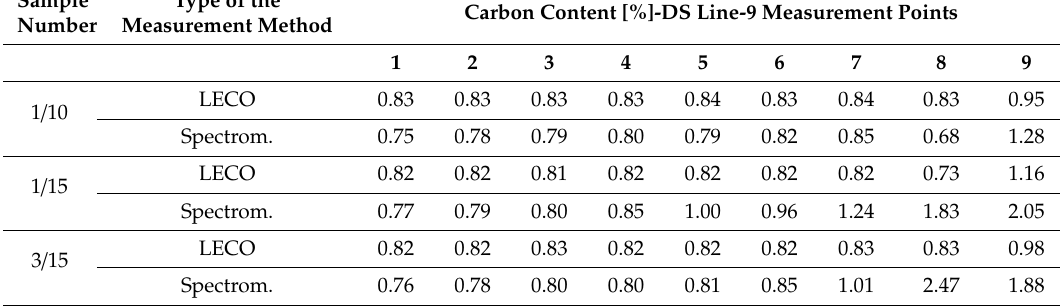
Table 2. Summary of analyses of carbon content in random samples, performed with a LECO analyser and with a spark spectrometer (Spectrom.) for a casting speed of 2.5 m/min (Heat no.2).